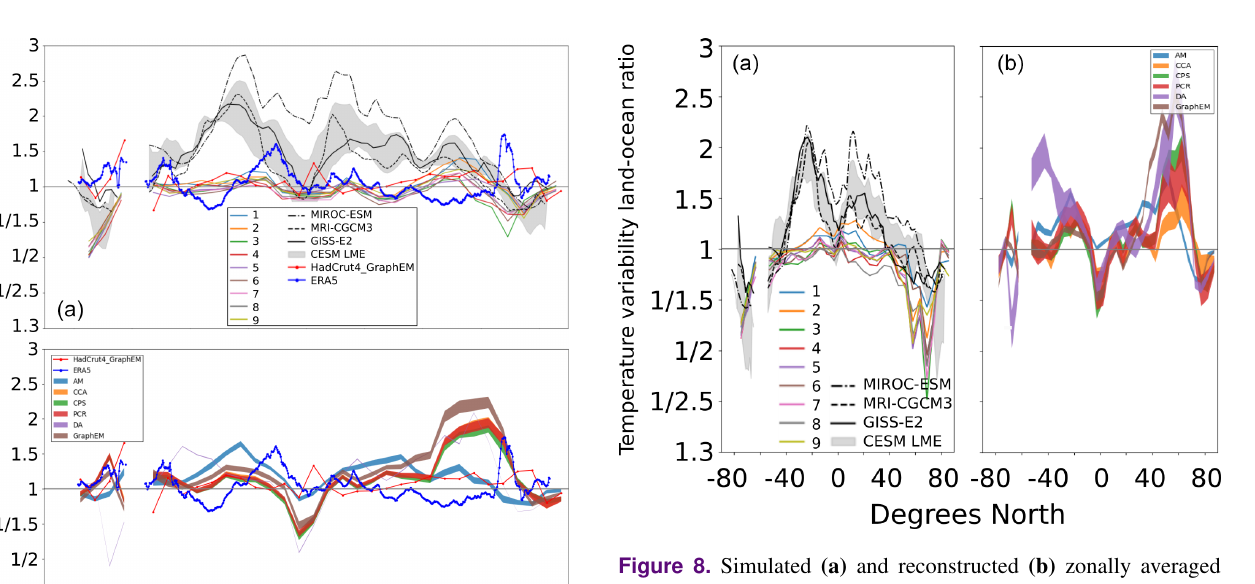
Figure 8. Simulated (a) and reconstructed (b) zonally averaged contrast in land–ocean temperature variability as a function of lat- itude. Atmospheric 2m temperatures over the oceans are used to calculate simulated ocean temperature variability. In (a) results are shown for the nine-member perturbed-parameter i LOVECLIM en- semble (numbers) and for four different CMIP5 simulations for the last 1000 years. Grey shading shows the 1 σ range of all CESM en- semble members. Panel (b) shows the 100-member 1 σ range for all six different CFR methods. Note that the y -axis scale is non-linear, with for instance 1 / 1 . 5 or 1 / 2, meaning that there is 50% or 100% more variability over the ocean than there is over the continents. The corresponding temperature variability over the continents and the oceans can be found in Figs. A7 (model results) and A9 (recon- structions). The corresponding figure showing the simulated results when using SSTs instead of atmospheric 2m temperatures over the ocean can be found in Fig.